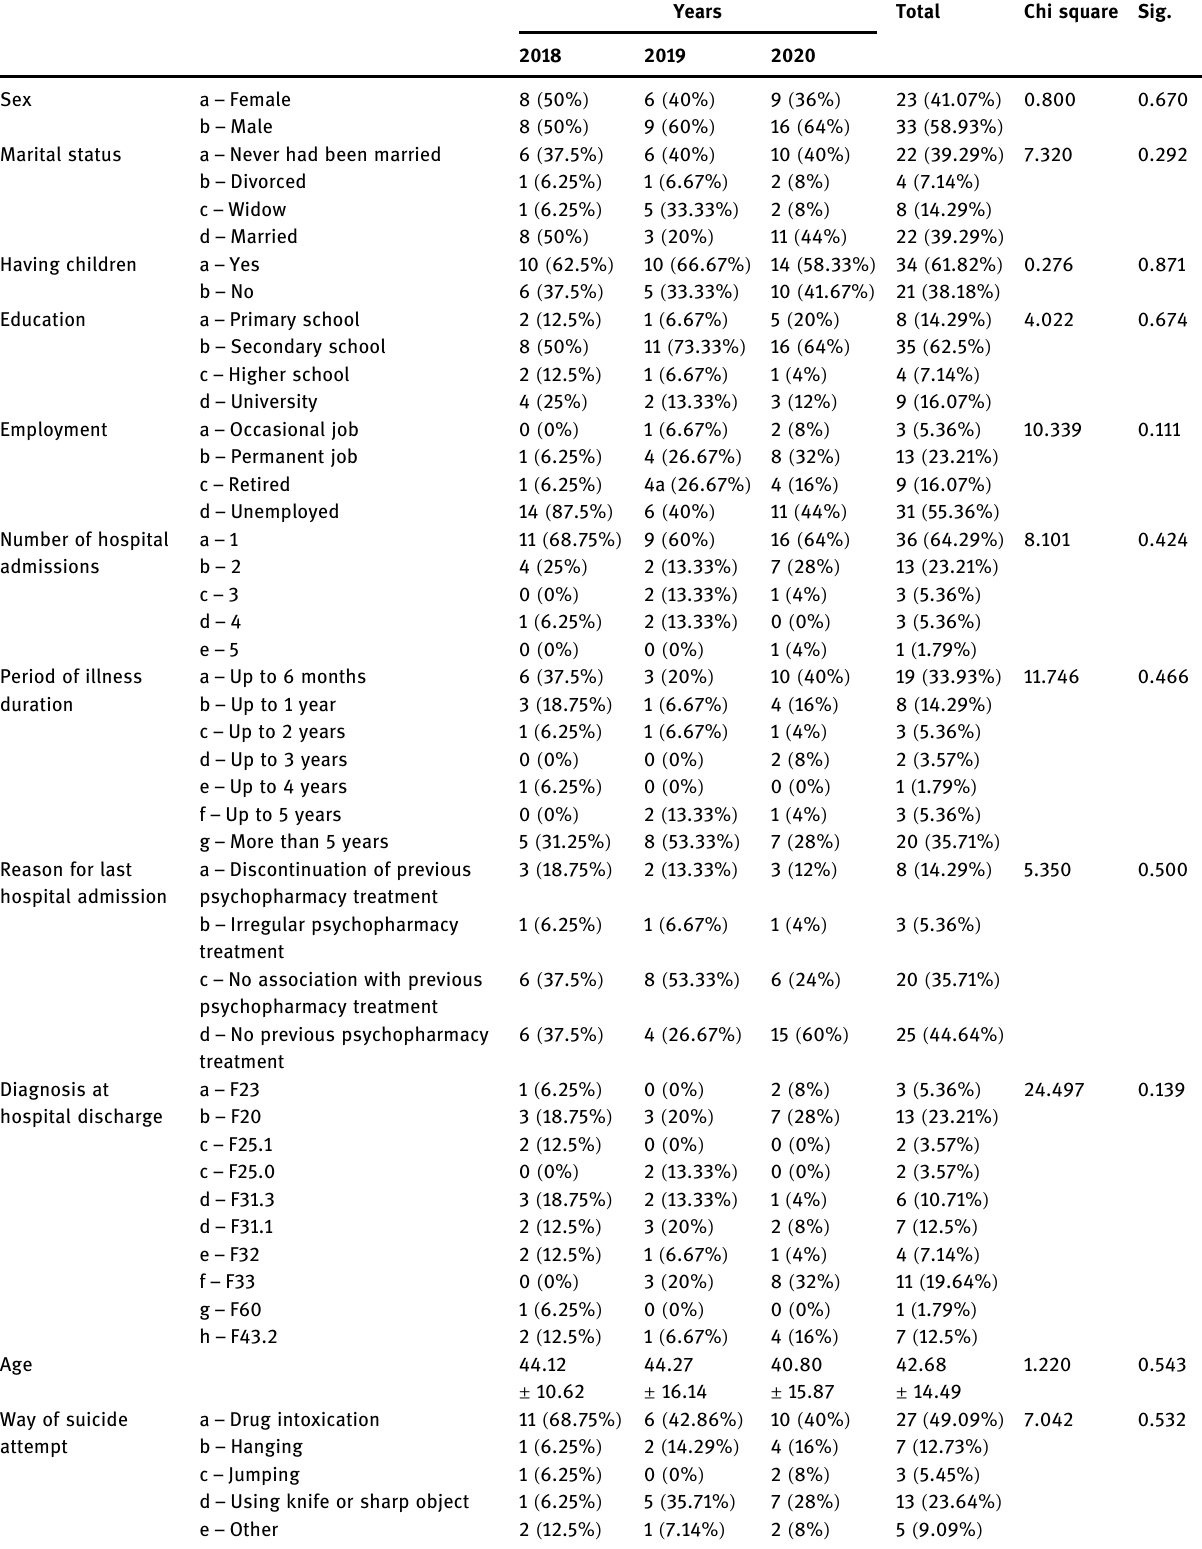
Table 3: Sociodemographic and clinical characteristics of all study subjects with suicide attempt Years Total Chi square